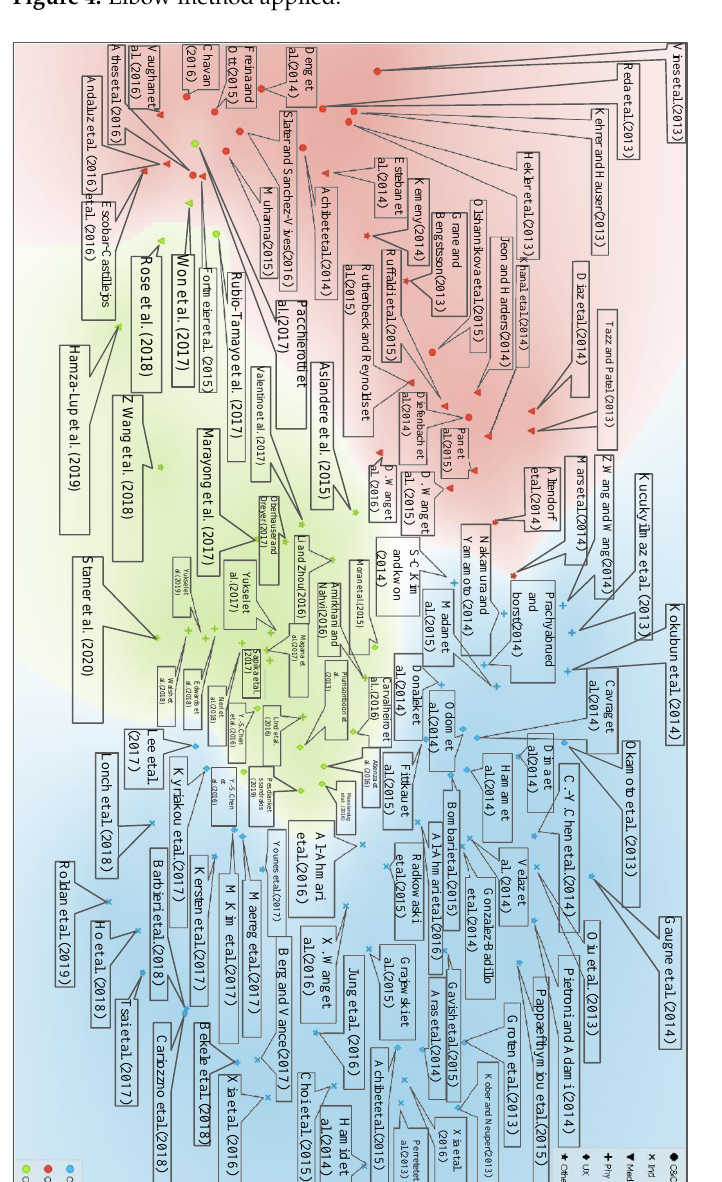
Figure 5. T-distributed Stochastic Neighbor Embedding (t-SNE) has been used for visualization of the relationship among papers. The image shows three cluster identified by dendrogram and the distribution of papers from each